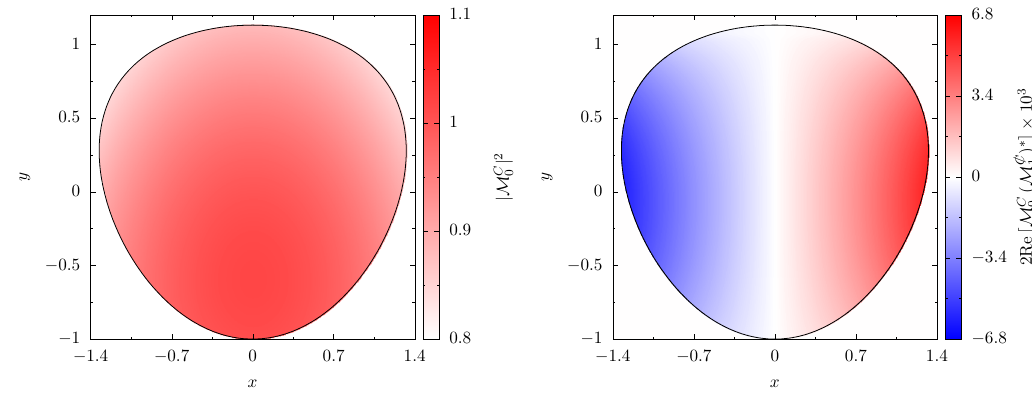
ηπ + π − : full Dalitz plot (left) and interference term →